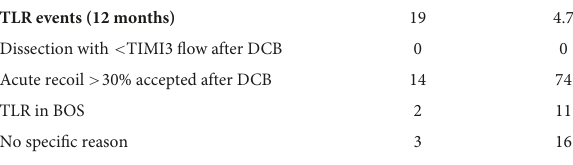
TABLE 5 Reasons for target lesion revascularization (TLR) after DCB (drug-coated balloon)-only percutaneous coronary intervention. TLR events (12 months) 19 Dissection with < TIMI3 flow after